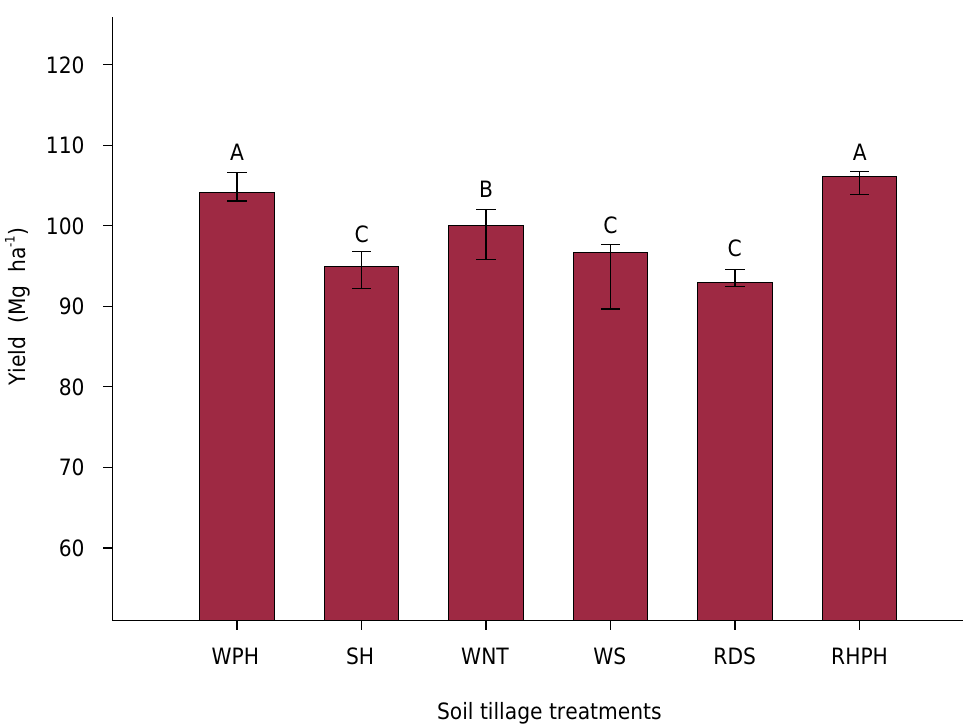
Figure 2. Sugarcane yield in the area of crop renewal under different soil preparation procedures in the Brazilian Cerrado (savanna). Treatments: WPH = weed desiccation + moldboard plowing (0.4 m) + mild spike tooth harrowing (0.15 m); SH = subsoiler (0.3 m) + mild spike tooth harrowing (0.15 m); WNT = weed desiccation + no-tillage (only furrow opening); WS = weed desiccation + subsoiler (0.4 m); RDS = ratoon destruction + subsoiler (0.40 m); RHPH = ratoon destruction + spike tooth harrowing (0.2 m) + moldboard plowing (0.4 m) + mild spike tooth harrowing (0.15 m). The same uppercase letters do not differ for soil preparation procedures by Tukey’s test at 5 % significance. CV = 4.8